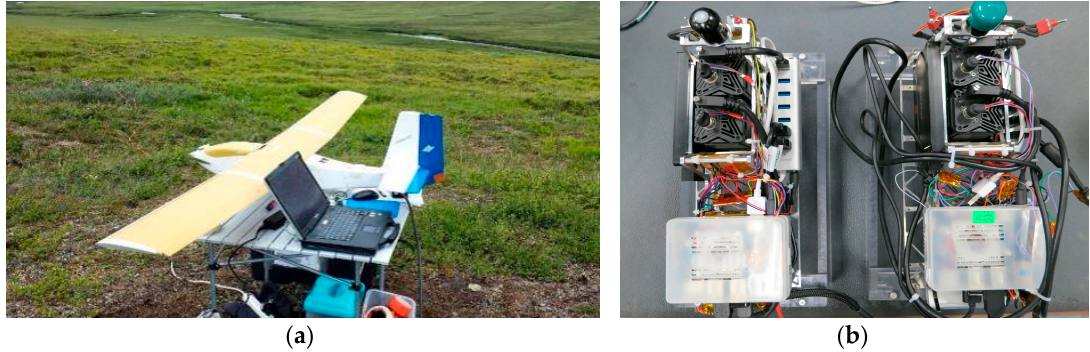
Figure 3. An example of the AggieAir “Minion” sUAS Fixed Wing Aircraft ( a ); and AggieAir custom payload detail ( b ).